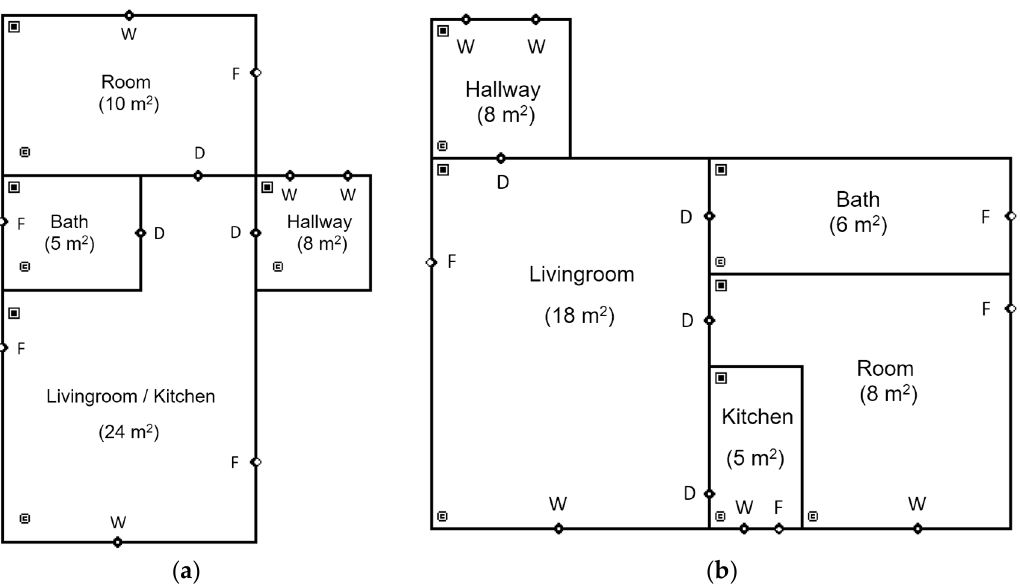
Figure 2. CONTAM SketchPad representation of ( a ) dwelling “A” and ( b ) dwelling “B”, including the surface of each room. The open diamonds represent the fans (denoted with letter F), windows (W), and doors (D). The filled squares indicate the individual zones. The open squares with the letter “C” inside indicate the sources of the radon contaminant. Table 1. Description of the parameters used as input for the simulation. The hallway is the same for both dwelling “A” and dwelling “B”.